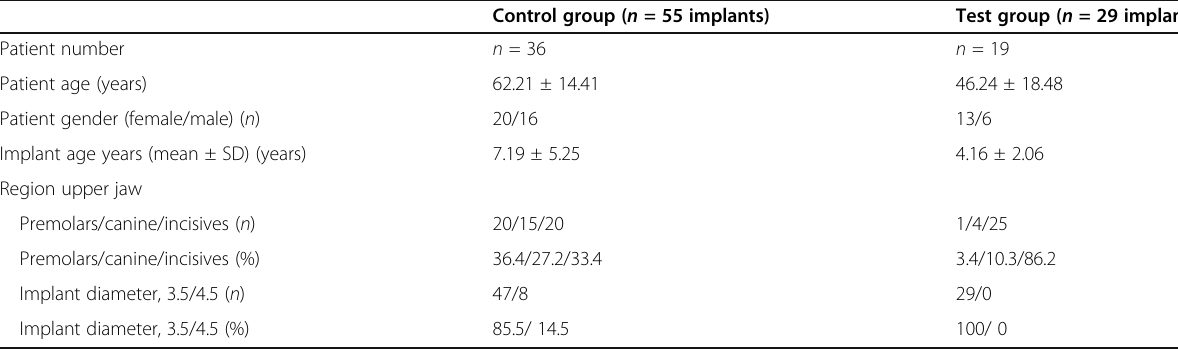
Table 1 Patient and implant site